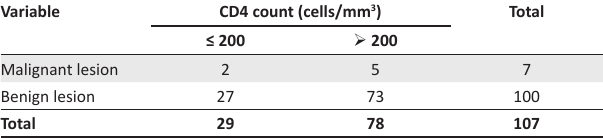
TABLE 3: CD4 count: Effect of CD4 count on malignant lesions.